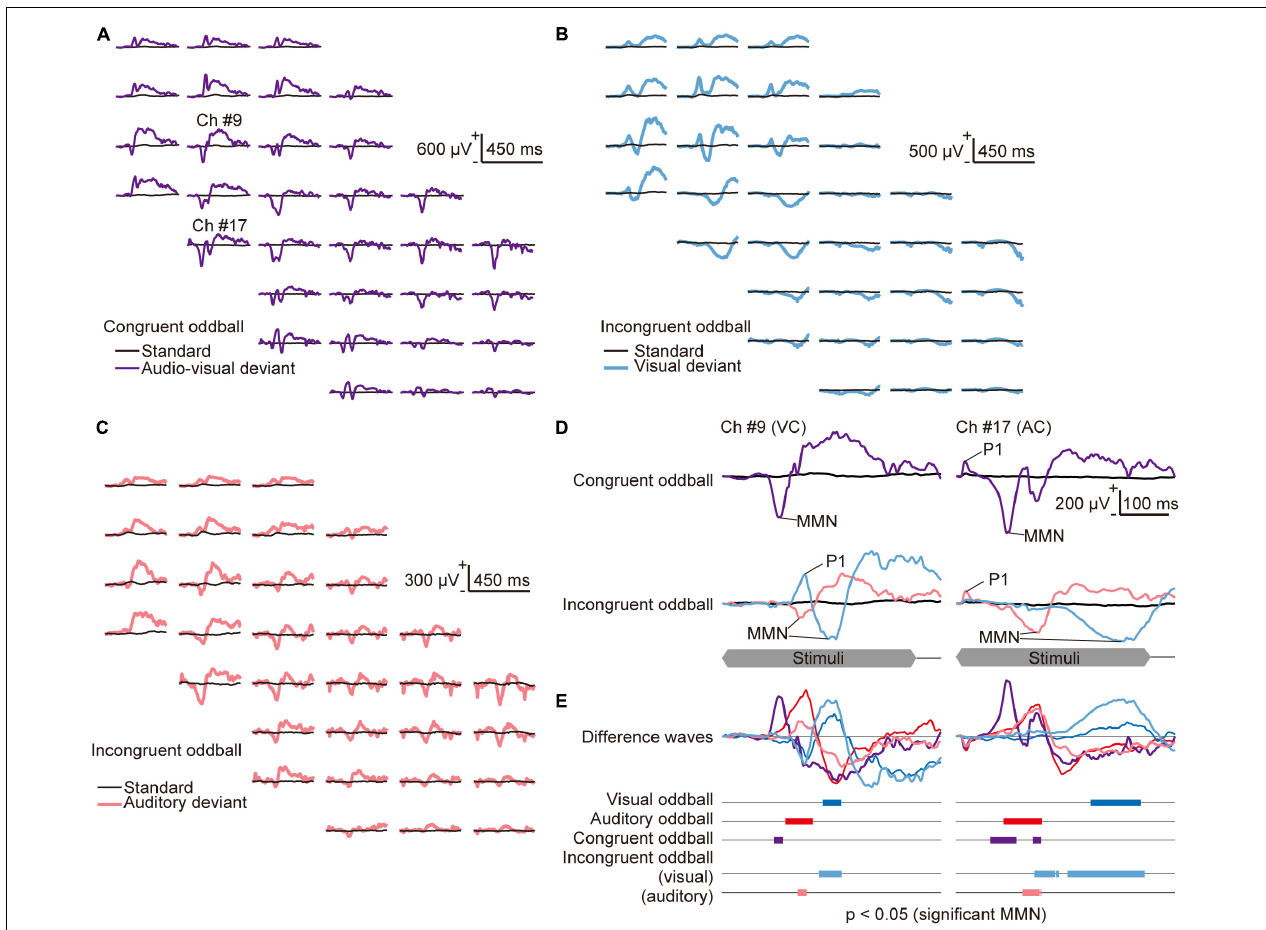
FIGURE 4 | Mapping of the congruent and incongruent audio-visual mismatch negativity (avMMN). (A–C) Representative mapping of responses recorded (A) in the congruent audio-visual oddball paradigm, where the auditory and visual deviant stimuli were always presented together (purple lines), and ( B–C) in the incongruent audio-visual oddball paradigm, where (B) the visual deviant (light blue lines) and (C) the auditory deviant (pink lines) were delivered independently. Both incongruent oddball paradigm maps show the same standard (black lines) responses. (D) Responses in the congruent oddball (top) and the incongruent oddball (bottom) paradigm from the indicated recording sites in the visual (left, #9) and auditory cortices (right, #17). The time course of stimulus presentation is indicated at the bottom of the inset. (E) Difference waves obtained by subtracting the deviant responses from the standard responses in all tested oddball paradigms: visual oddball (blue lines), auditory oddball (red lines), and congruent audio-visual oddball (purple lines). In the incongruent audio-visual oddball paradigm, the difference wave between the standard, visual-deviant (light blue), and auditory-deviant responses (pink) are shown separately. The bars in the bottom inset represent time courses of each MMN, i.e., the latencies when significant differences were found under the null hypothesis that deviant responses are larger than standard responses (Wilcoxon one-sided rank-sum test with Bonferroni correction for 450 comparisons).